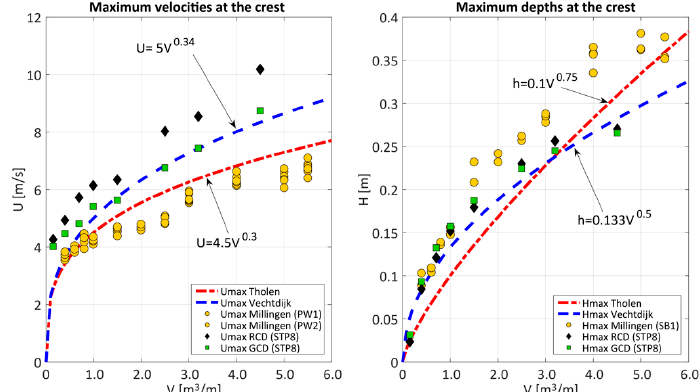
Figure A1. Validation of crest maximum velocity ( Left ) and maximum flow depths ( Right ) at PW1, SB1,